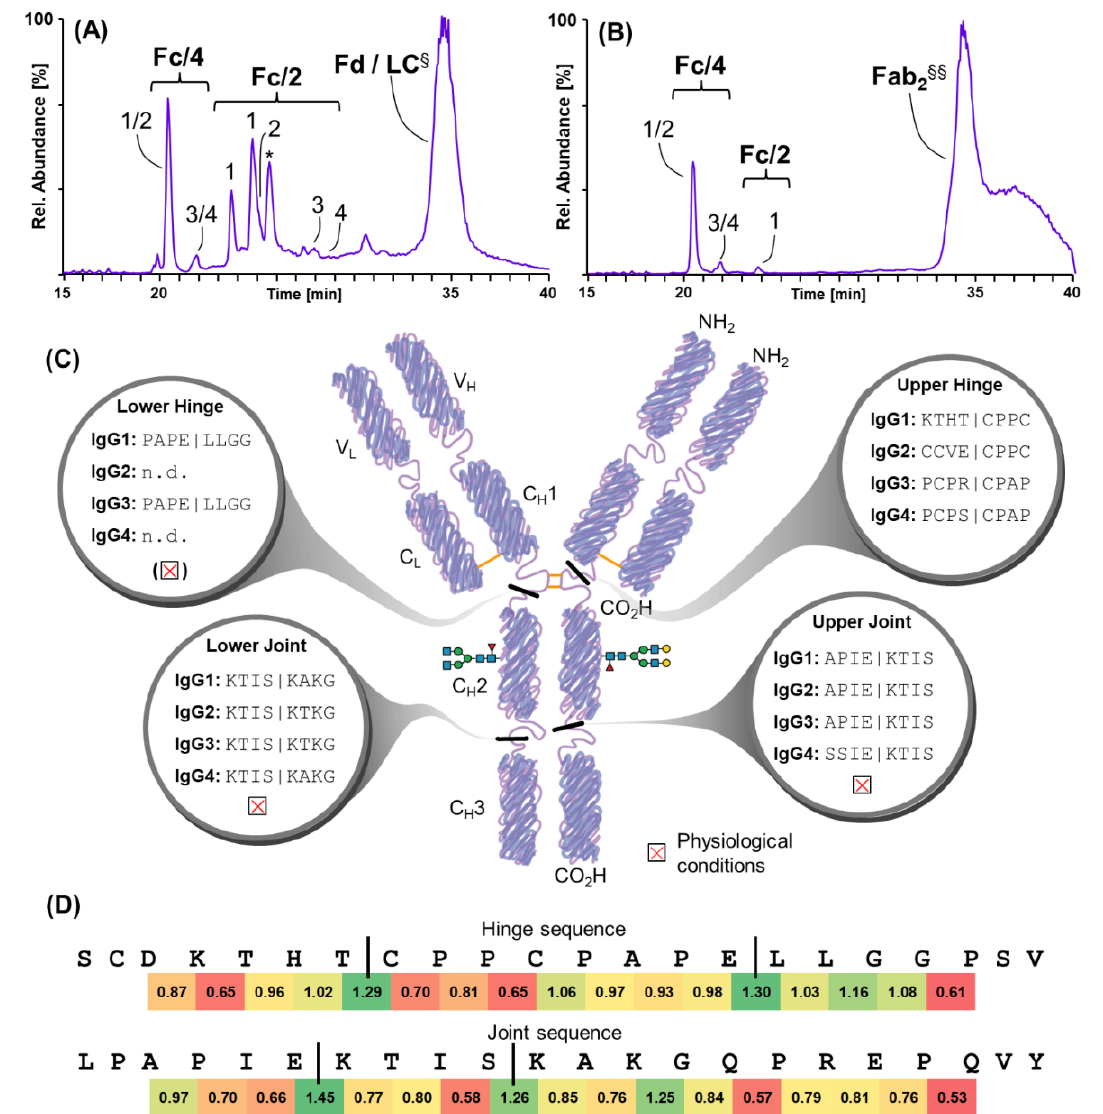
Figure 5. Proteolysis of IgG subclasses by SpeBm. Total ion chromatograms of human polyclonal IgG digested by SpeBm under ( A ) reducing or ( B ) physiological conditions. Main cleavage products are annotated: fragment crystallizable (Fc) and fragment antigen-binding (Fab), as well as their derivatives. Numbers denote the corresponding subclasses from which these subunits originate. Single peaks may be annotated by multiple numbers, as proteolytic products from different subclasses may co-elute. The asterisk (*) denotes a chromatographic peak corresponding to an incompletely alkylated IgG1 subunit cleaved at KTHT|CPPC. § Putative chromatographic peak of the Fd subunit and the light chain (LC). §§ Putative chromatographic peak of Fab 2 and Fab 2 -comprising C H 2 domains. The exact nature of these species could not be determined due to the high amino acid sequence variability of their variable portions and was derived from the identified cleavage sites. ( C ) SpeBm cleavage sites are mapped to a schematic of an IgG1 antibody for all four subclasses in a combined manner. Whether the cleavage also occurs under physiological conditions is specified in the respective small box with a red cross. ( D ) Likelihood of cleavage sites calculated for the hinge region (upper sequence) and the joint region (lower sequence) of IgG1. High green values suggest likely cleavage, whereas low red values suggest unlikely cleavage. Values were calculated based on amino acid occurrences relative to natural abundance of combined tryptic and GluC PICS data, considering P3 to P3 (cid:48) . Black vertical lines show experimentally observed